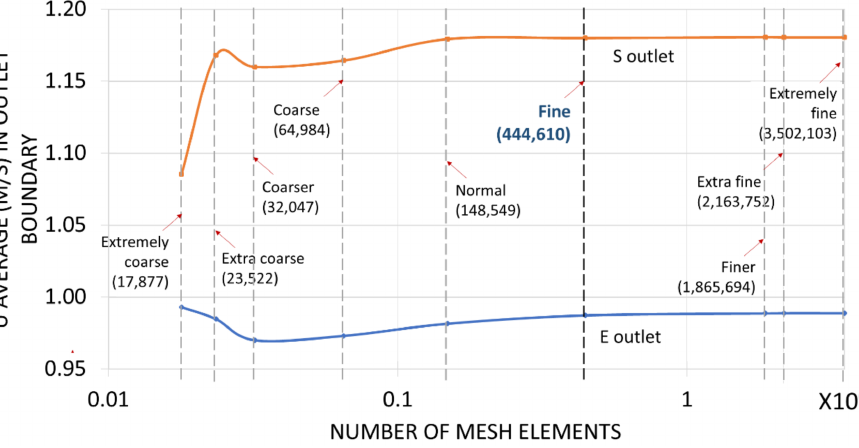
Figure 6. Mesh sensibility